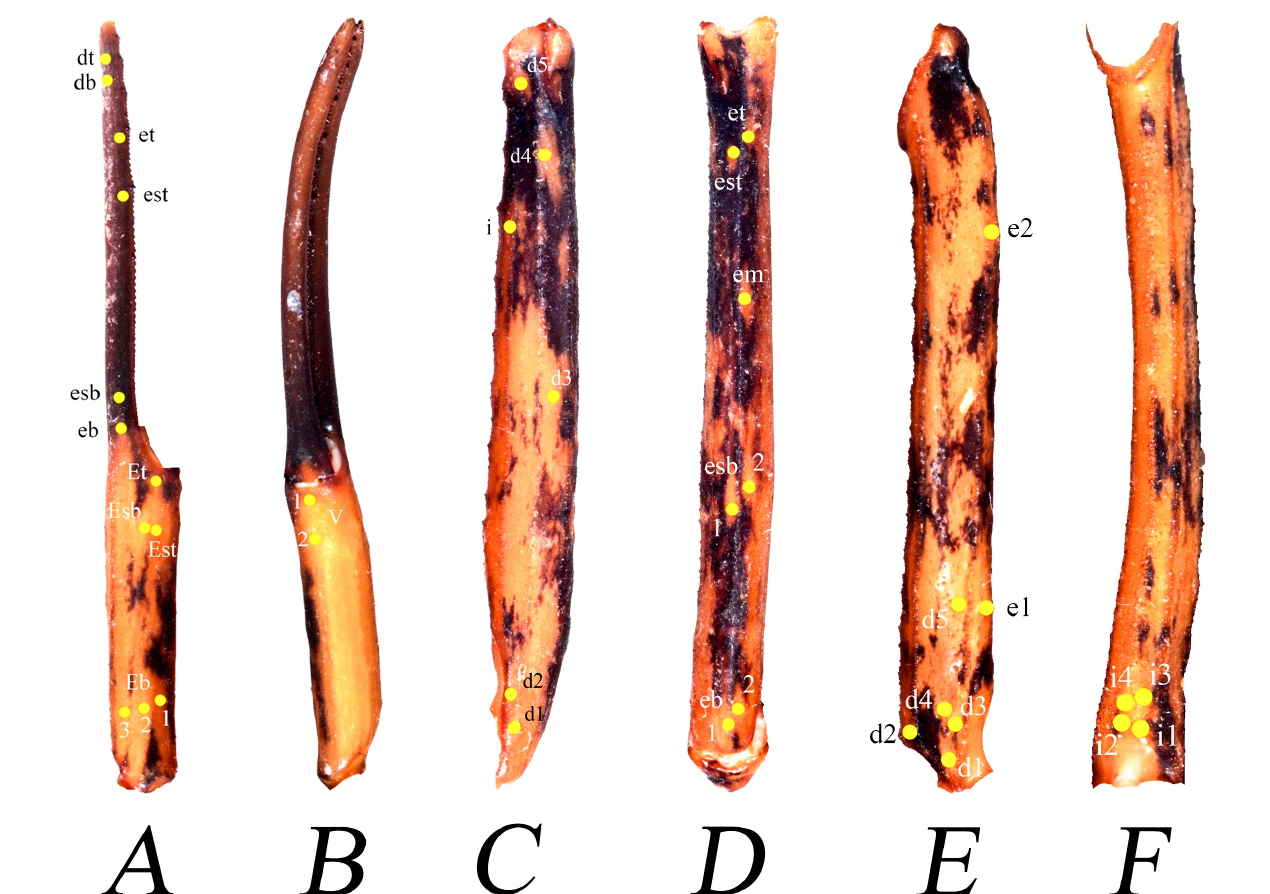
Fig. 10. Isometrus nakshatra sp. nov., holotype, adult ♂ (BNHS SC 195). A–B . Pedipalp chela. A . Dorsal view. B . Ventral view. C–D . Patella. C . Dorsal view. D . External view. E–F . Femur. E . Dorsal view. F . Internal view. Trichobothrial pattern indicated by yellow